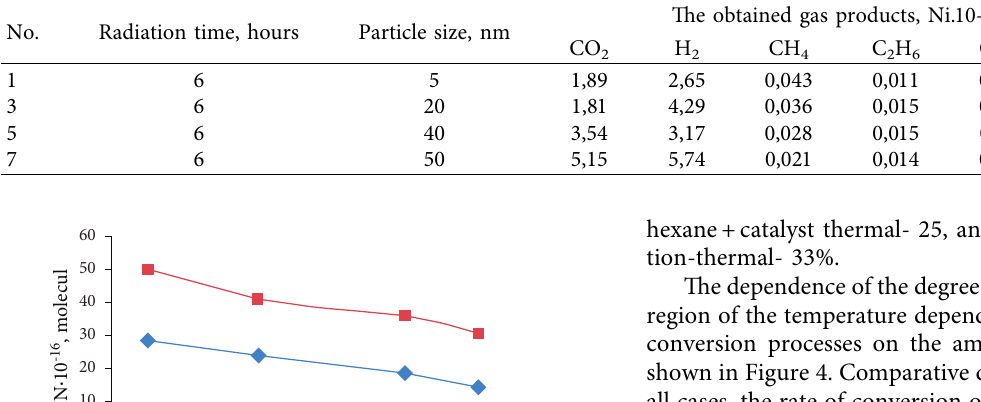
2 O 3 of The obtained gas products, Ni.10-16, molecules/ml